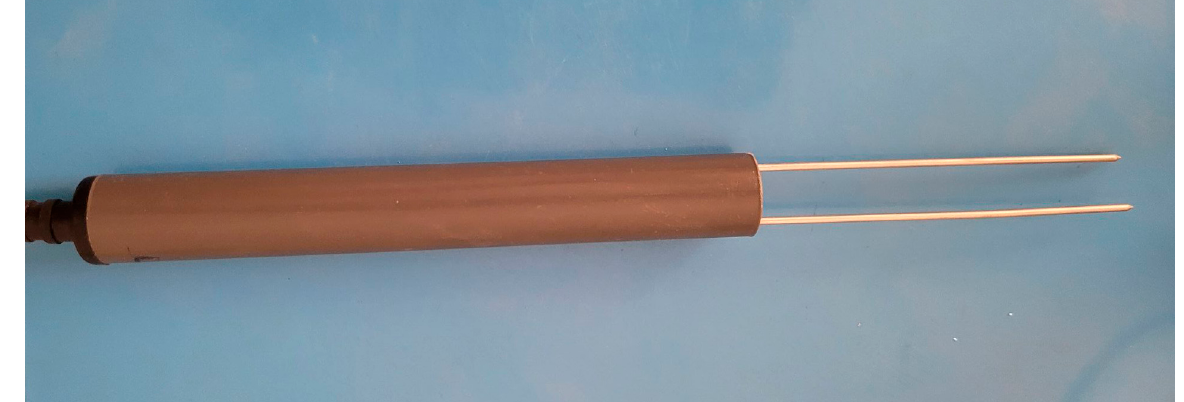
Figure 1. FP/mts TDR sensor applied in this research (ETest, Lublin, Poland).